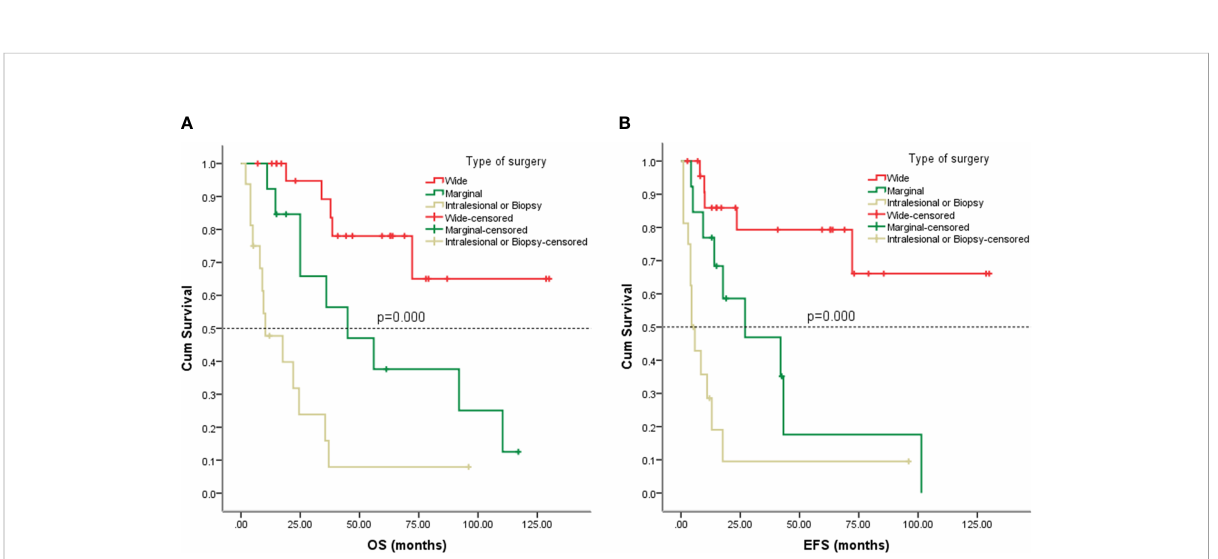
FIGURE 5 Kaplan-Meier analysis of OS and EFS for patients with different types of surgery. (A) Kaplan-Meier analysis of OS for patients with different types of surgery (p=0.000). (B) Kaplan-Meier analysis of EFS for patients with different types of surgery